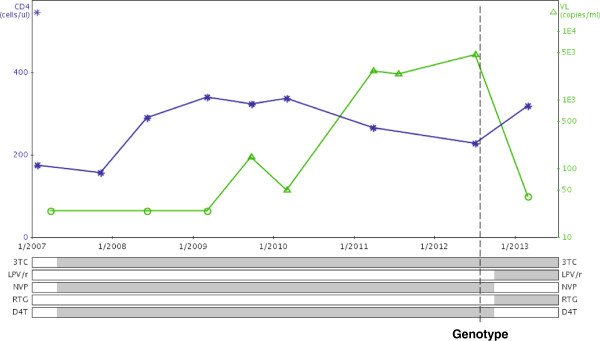
Graphical display of antiretroviral history and viral load/CD4+ cell count measurements (Case example 2).